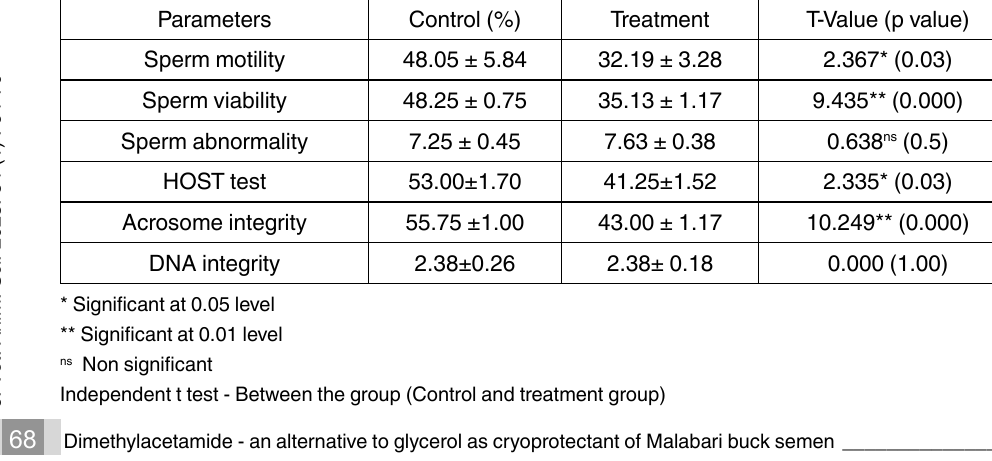
table 4. The effect of glycerol and DMA on post-freeze semen variables of Malabari buck